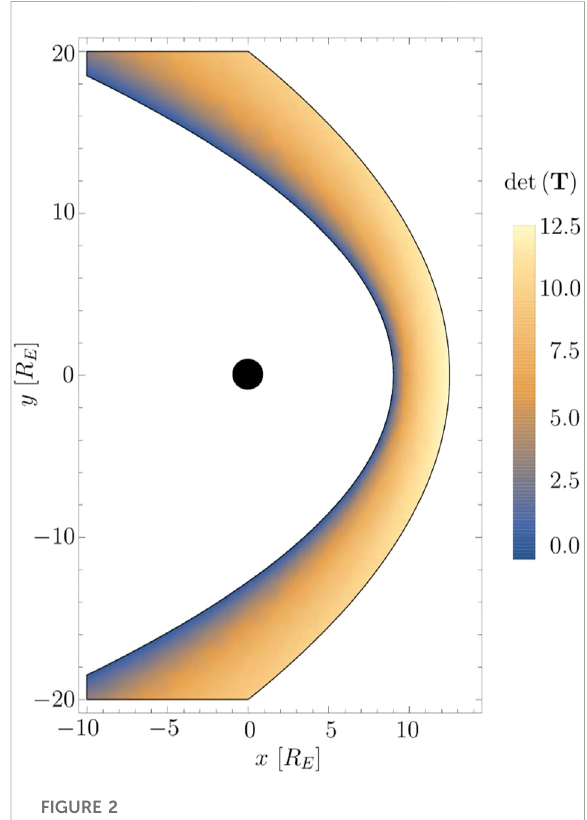
FIGURE 2 Determinant of the matrix T in the x - y plane. The matrix becomes singular at the